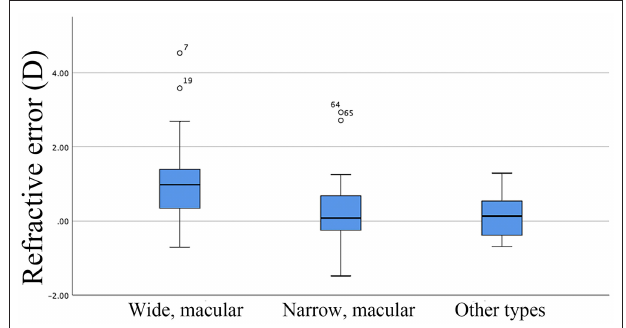
FIGURE 2 | Distribution of postoperative refractive errors in different posterior staphyloma groups.